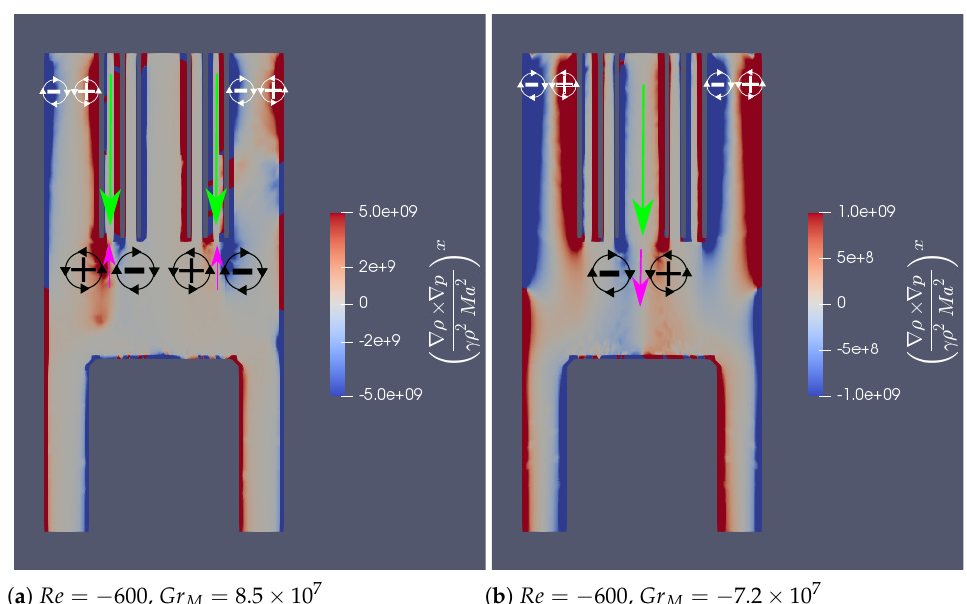
Figure 9. Vertical cut through the down-flow reactor depicting the distribution of the x − component of the baroclinic term. Black circles denote the baroclinic torque due to molar mass gradients. White circles denote the baroclinic torque due to thermal gradients. Green arrows give the intended direction of flow, and purple arrows denote the acceleration of the fluid due to the baroclinicity. ( a ) Variation of NH 3 in the ORL. ( b ) Variation of H 2 in the